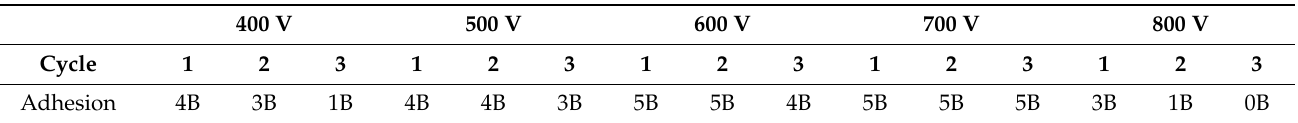
Table 3. Adhesion strength results of the ink-jet printed conducting layer with IPL-sinterable nano Cu ink after IPL sintering (ASTM D3359).